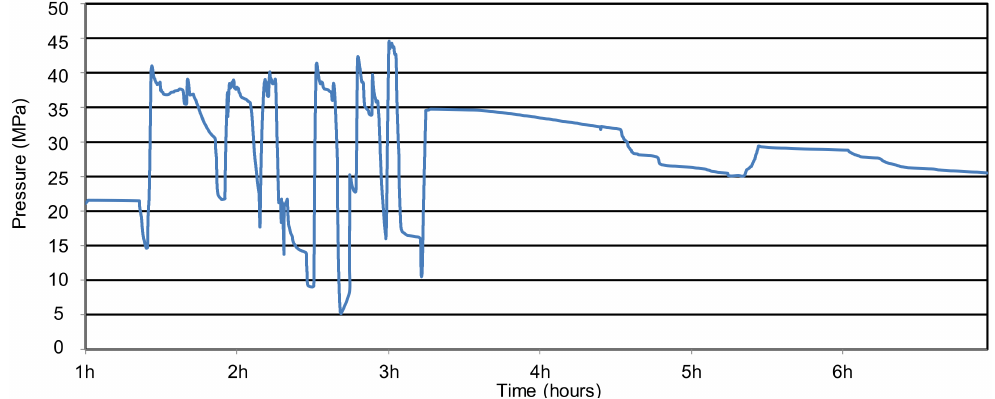
Figure 9. Registered excess of the nominal support.